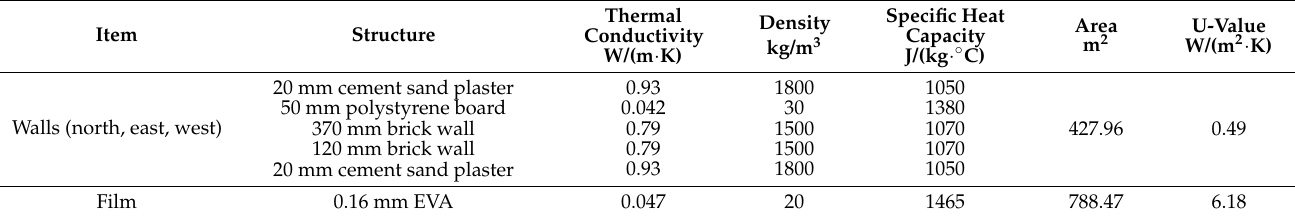
Figure 1. Sectional drawing of the typical solar greenhouse design (lengths in mm). Table 1. Thermal parameters of the enclosure structure.